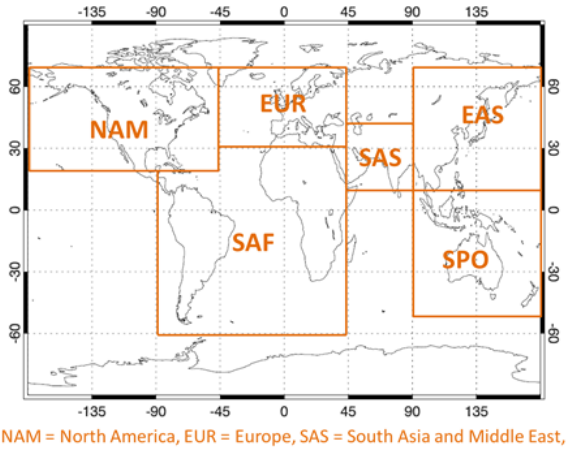
Figure 1. Definition of emission source regions in this